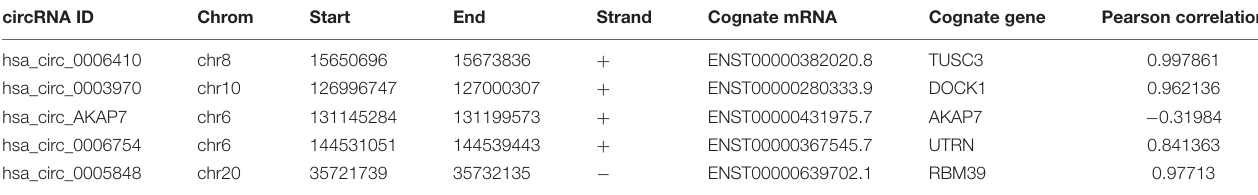
TABLE 1 | The detailed information of circRNAs.